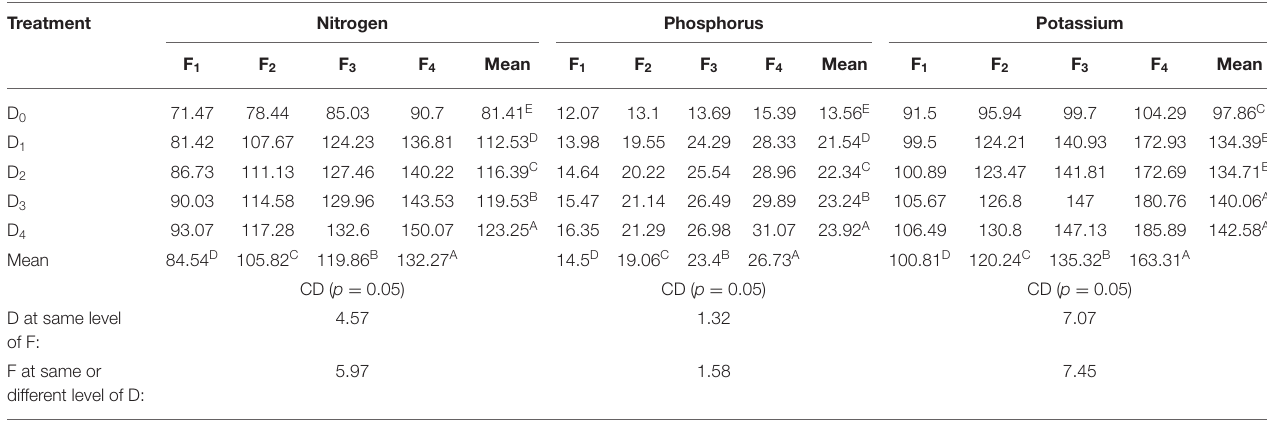
TABLE 6 | Interaction effect of recommended dose of fertilizer (RDF) and panchagavya on total nutrient (grain + straw) uptake (kg ha − 1 ) by hybrid basmati rice. Treatment Nitrogen